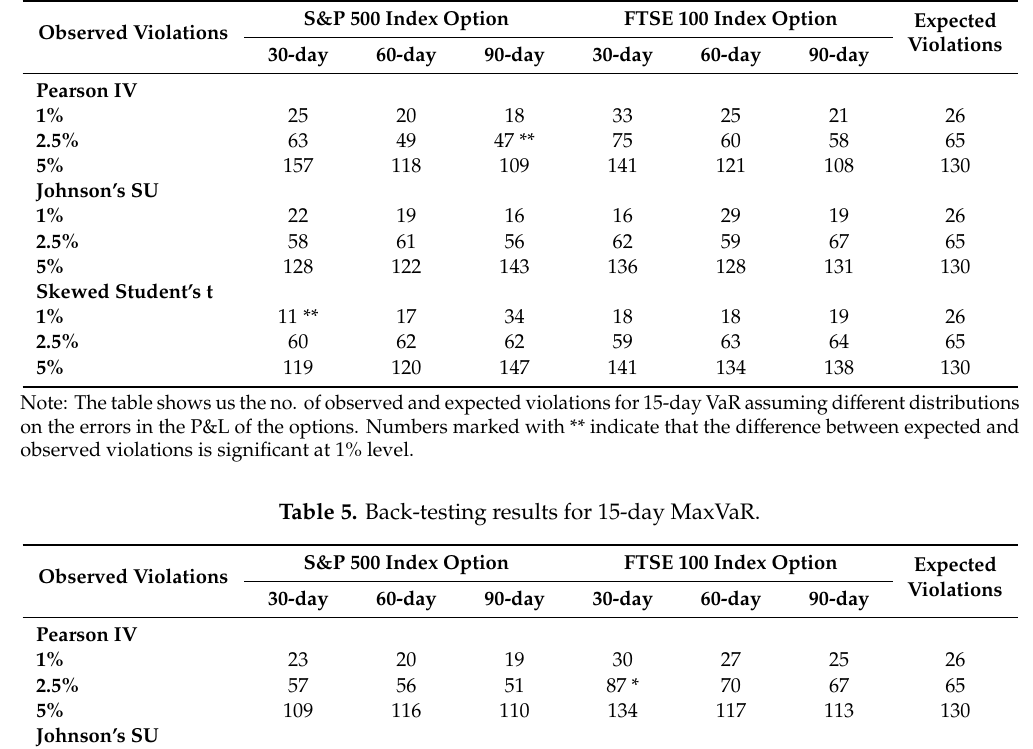
Table 4. Back-testing results for 15-day VaR.